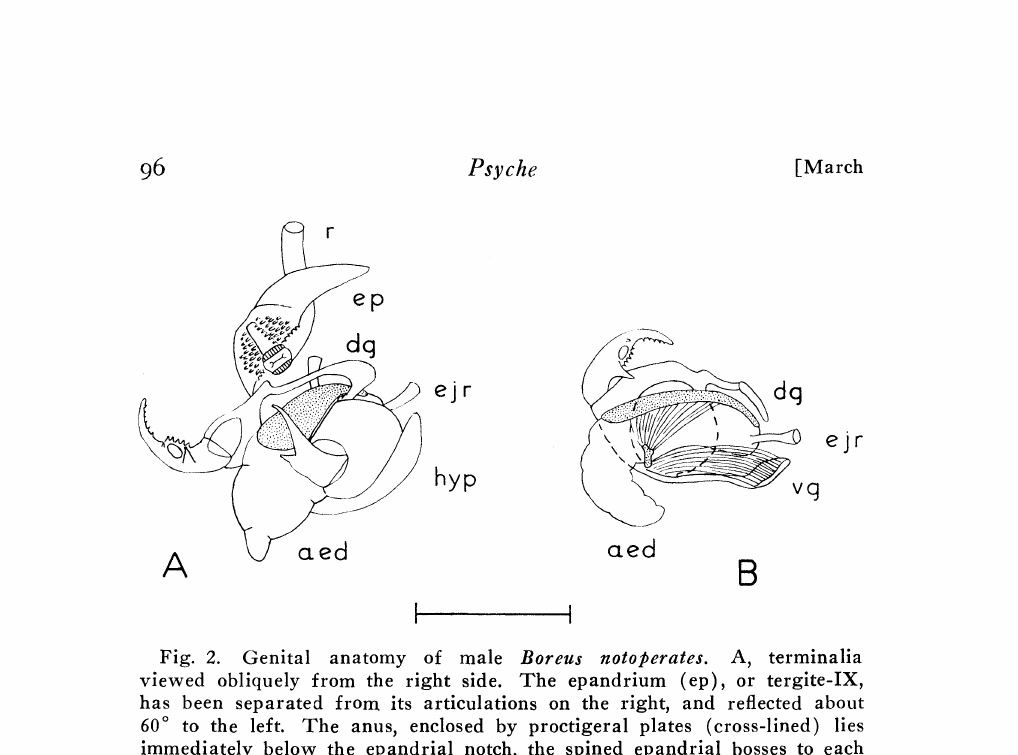
Fig. 2. Genital anatomy of male Boreus notoperates. A, terminalia viewed obliquely from the right side. The epandrium (ep), or tergite-IX, has been separated from its articulations on the right, and reflected about 60 to the left. The anus, enclosed by proctigeral plates (cross-lined) lies immediately below the epandrial notch, the spined epandrial bosses to each side. Gonostyles abducted on right, displaying in profile the short, sharp medial tooth which engages the lateral basal notch of the gonapophysis. The dorsal gonobase (dg) extends anteriorly from the gonocoxites, flaring out as the roof of the anterior end of the endandrium. Median plaque (stip- pled) immediately over the aedeagus forms the floor of the endandrium; aedupartially everted aedeagus, ejrmright ejaculatory duct, hyp--hy- pandrium, rectum. B, partially exserted aedeagus (aed), right lateral view. Epandrium, proc- tiger, right gonocoxite and hypandrium have been removed. Above, dg, the left dorsal half of the gonobase; below, vg, the left ventral half of the gonobase. Sclerotized plaque (stippled) overlying the aedeagus joined by a fan of muscles to U-shaped scle.rite (stippled) partially encircling the aedeagus ventrally. The genital chamber is the space enclosed between the ,dorsal and ventral gonobases, the endandrium lies between the dorsal gonobase and the sclerotized plaque, and the aedeagal chamber lies between the sclerotized plaque and the ventral retractor muscle attached to the ventral gonobase; ejrmright ejaculatory duct. Both figures from camera |ucida drawings; scale equals 0.5